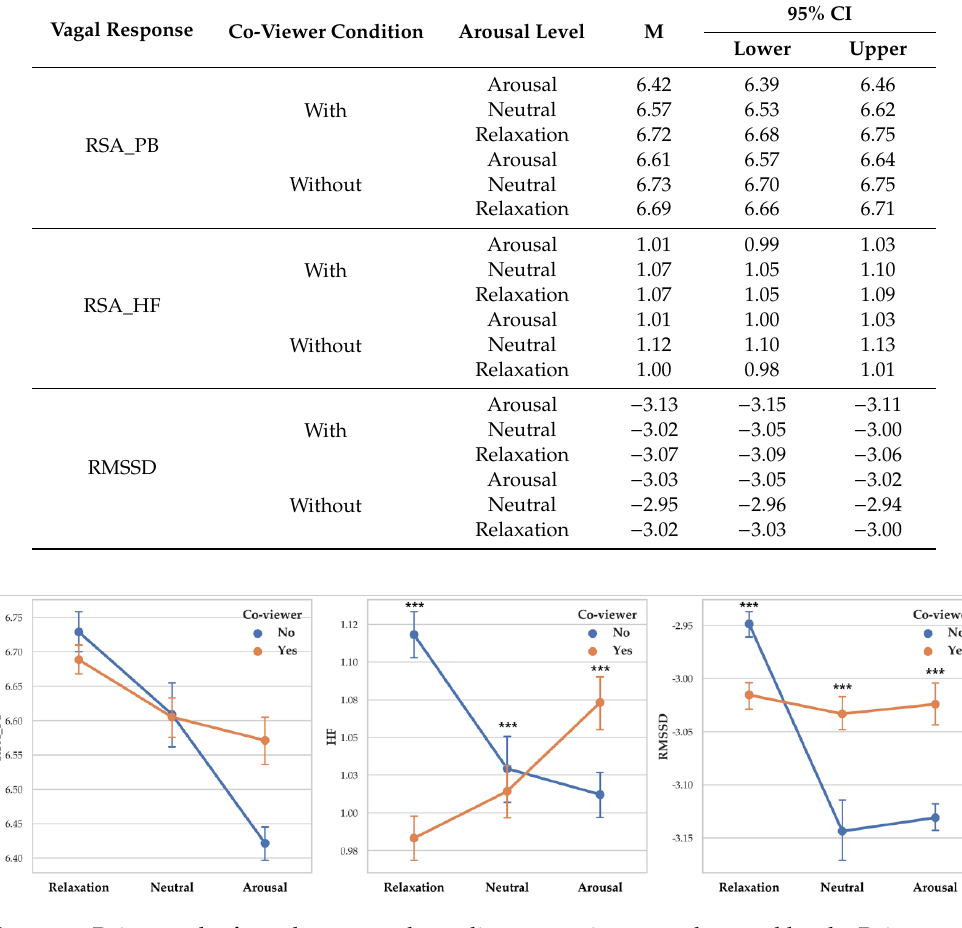
Table 15. Descriptive statistics for vagal response depending on existence of co-viewer and arousal.